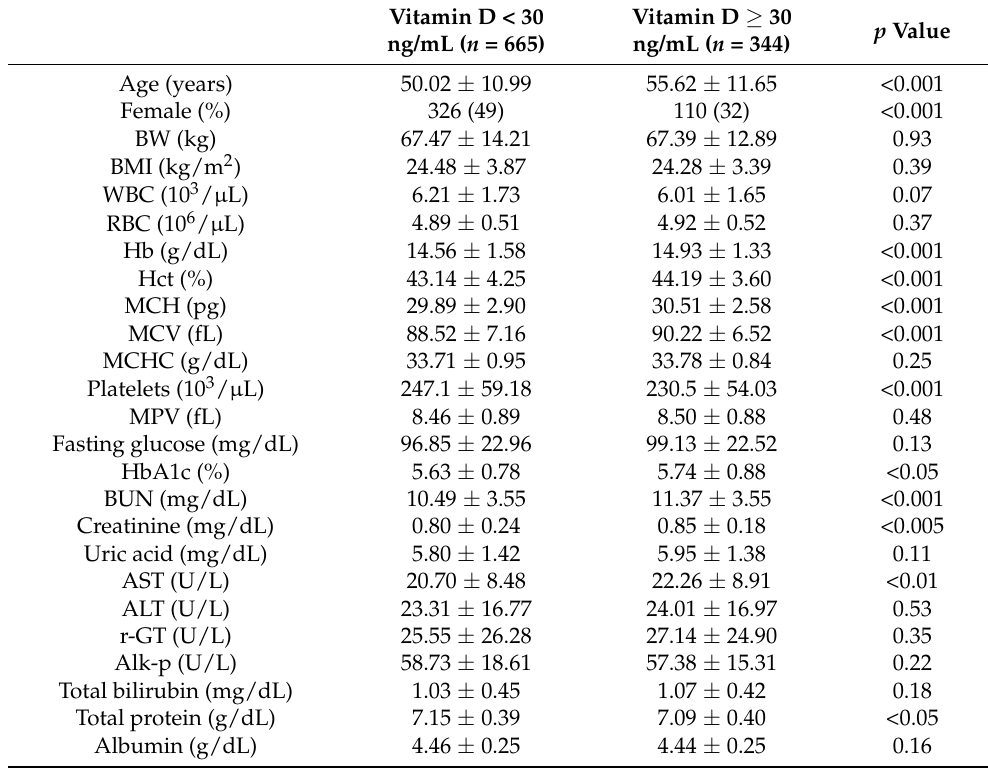
Table 1. Associations between vitamin D status and biomarkers in all